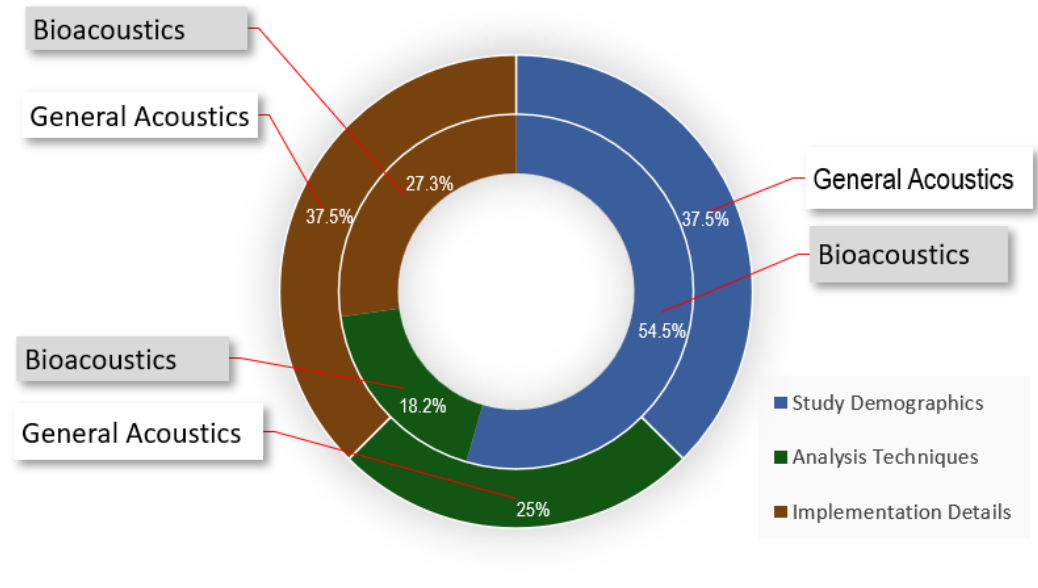
Figure 2. Analysis of previous reviews in acoustics